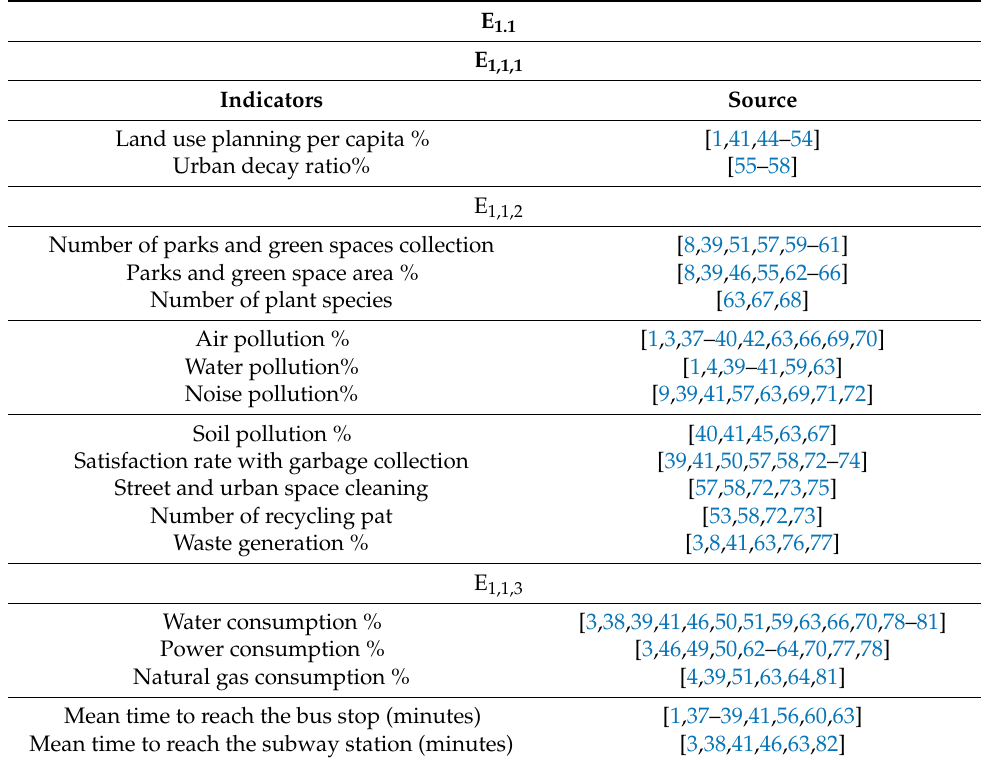
Table 3. Sources of